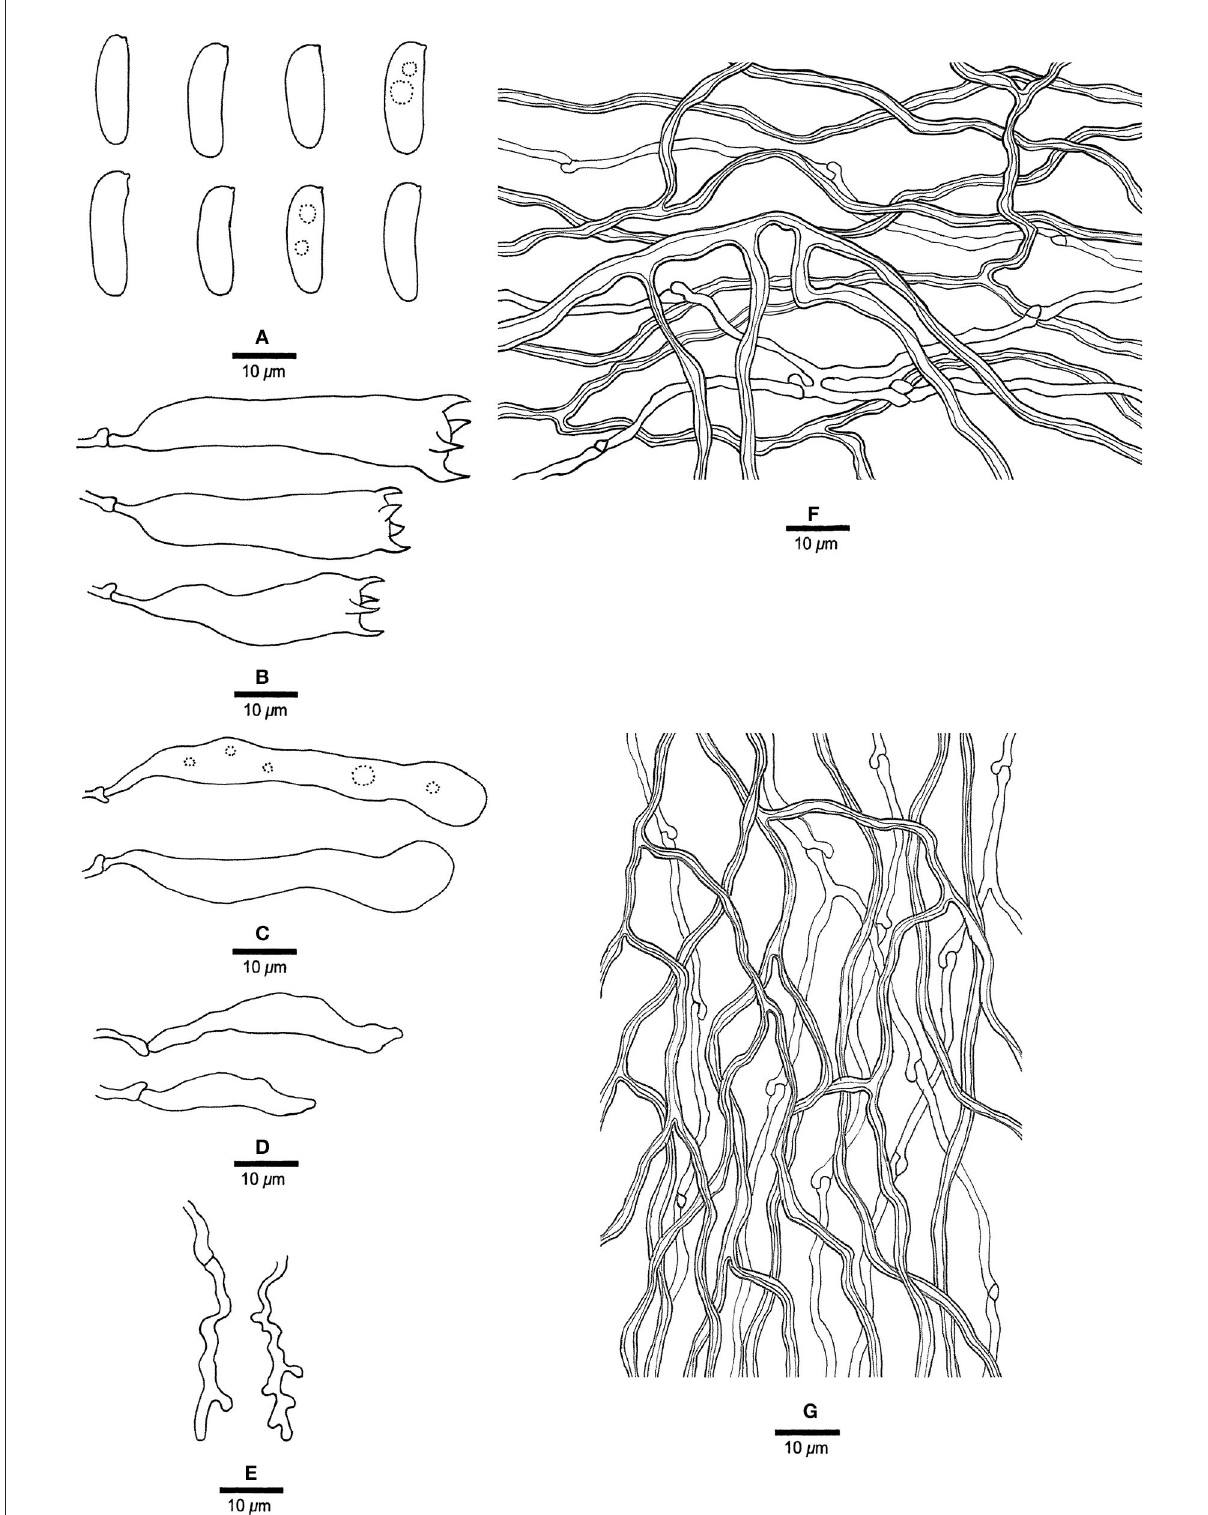
FIGURE12 Microscopic structures of Megasporia sinuosa (drawn from holotype, Dai 22210). (A) Basidiospores. (B) Basidia. (C) Basidioles. (D) Cystidioles. (E) Dendrohyphidia. (F) Hyphae from subiculum. (G) Hyphae from tube